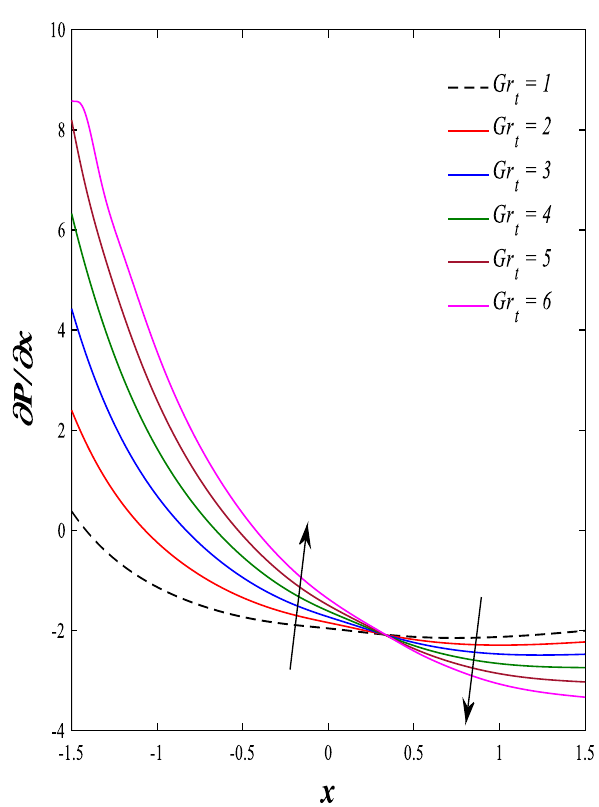
Figure 26. Effect of heat Grashof number Gr t on the pressure gradients